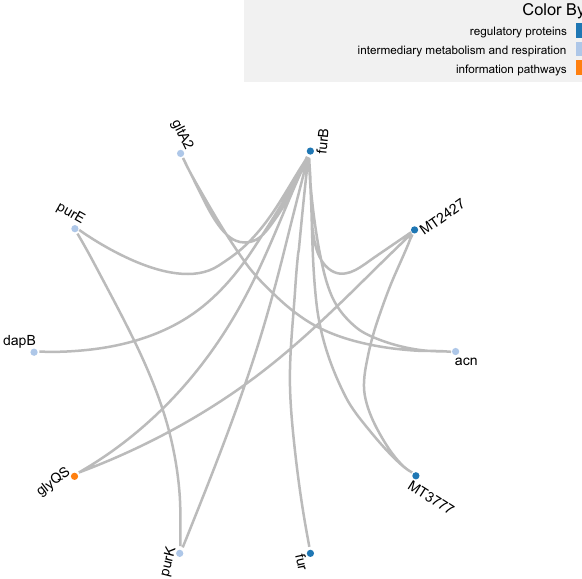
Figure 2. Mycobacterium tuberculosis proteins that interact with furB and the interactions between them (using Circle layout).